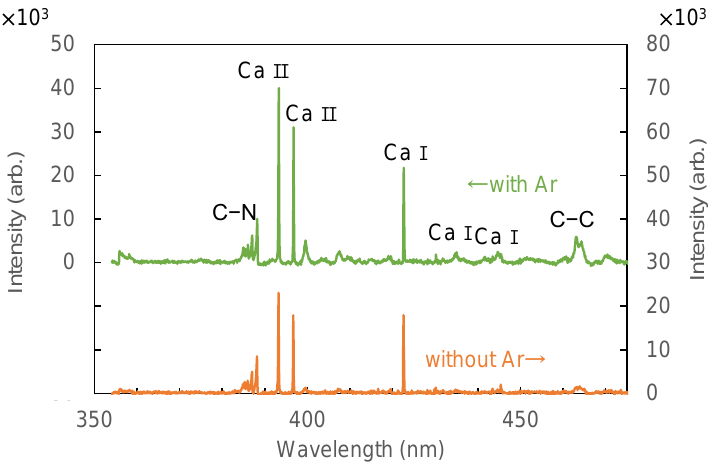
shows LIBS spectra of human hair measured with and without argon injection. Argon gas was injected from a nozzle set at a distance of 2 mm from the focused spot with a flow rate of 1 L/min. It was found that the peak intensity was enhanced approximately 1.8 times using argon injection; small peaks that can be attributed to C–N bond were observed at around 358 nm.